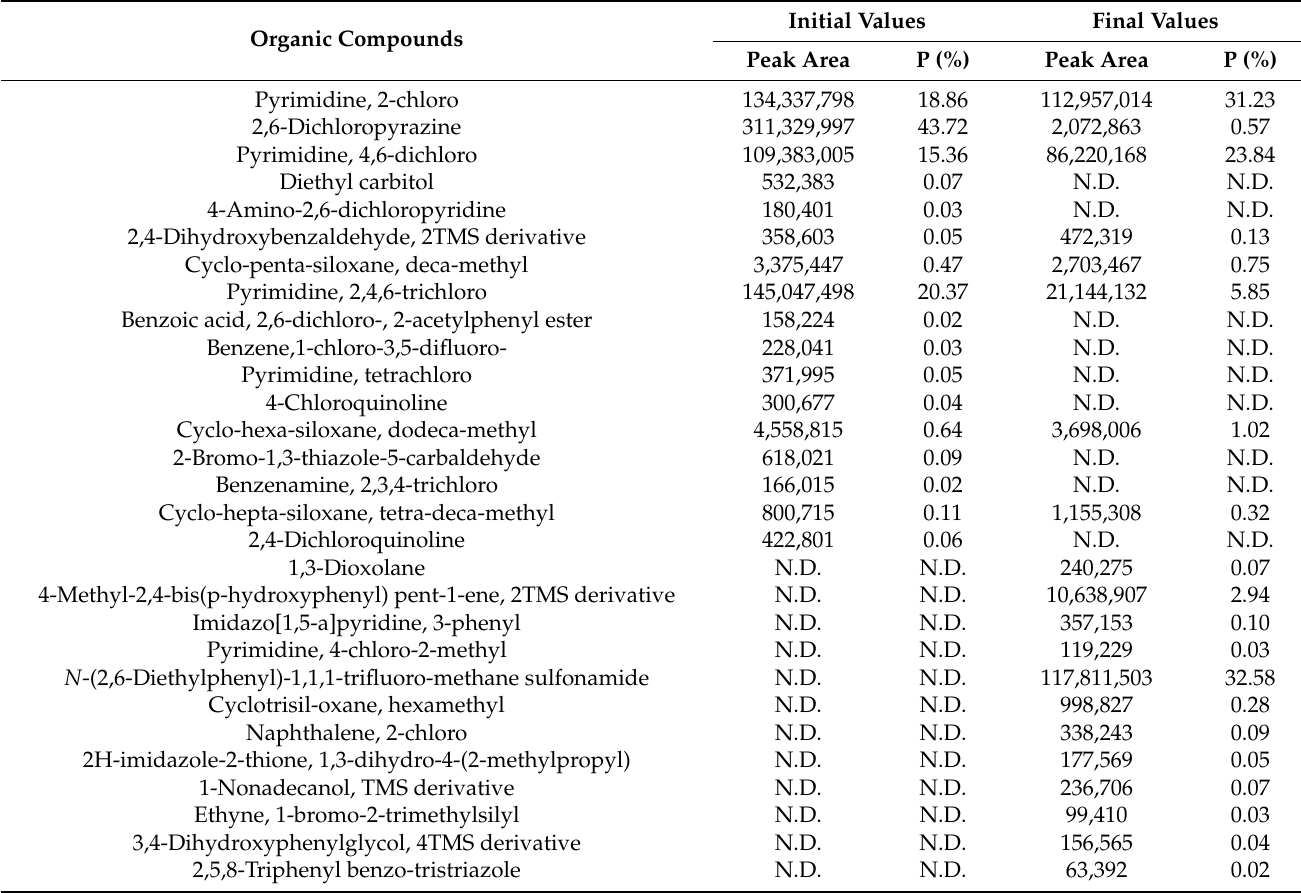
Table 2. Organic matter changes in pharmaceutical wastewater before and after the reaction. Initial Values Final Values Organic Compounds Peak Area P (%) Peak Area P (%)